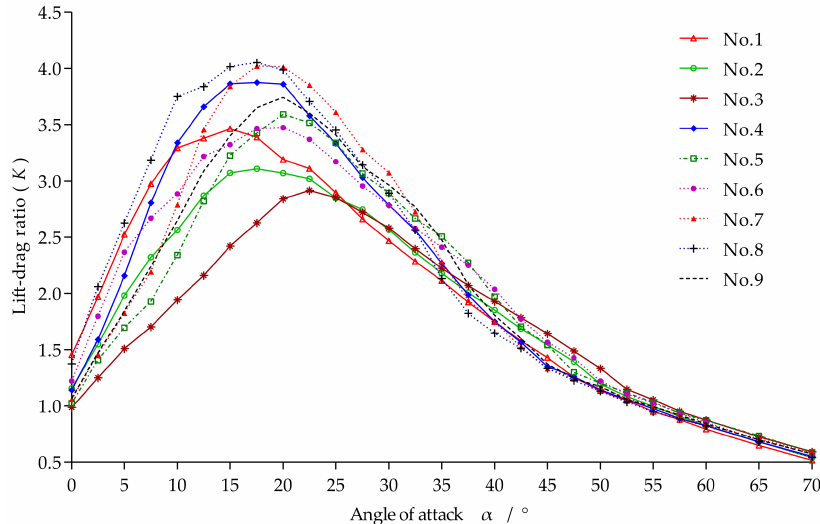
Figure 9. K versus the angle of attack α for the nine otter board